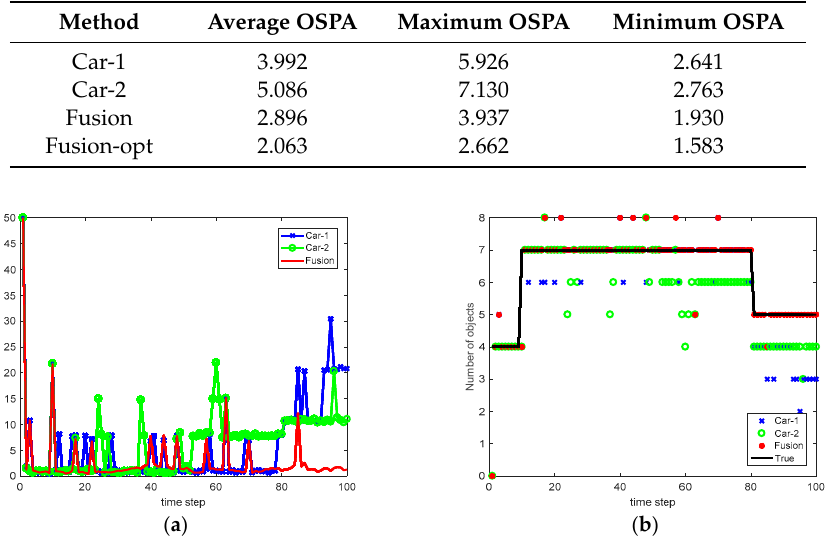
Table 2. Optimal subpattern assignment (OSPA) distance for multi-object tracking (MOT).